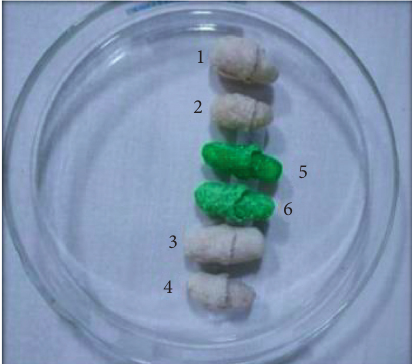
Figure 8: Capsule shells produced from the NCC of sugarcane bagasse waste mixed with hydroxypropyl methylcellulose (HPMC) and carbopol. (1) Capsules were produced at 1% NCC concen- tration +1% HPMC; (2) capsules were produced at 2% NCC concentration +1% HPMC; (3) capsules were produced at 4% NCC concentration +1% HPMC; (4) capsules were produced at 7% NCC NCC concentration +1%